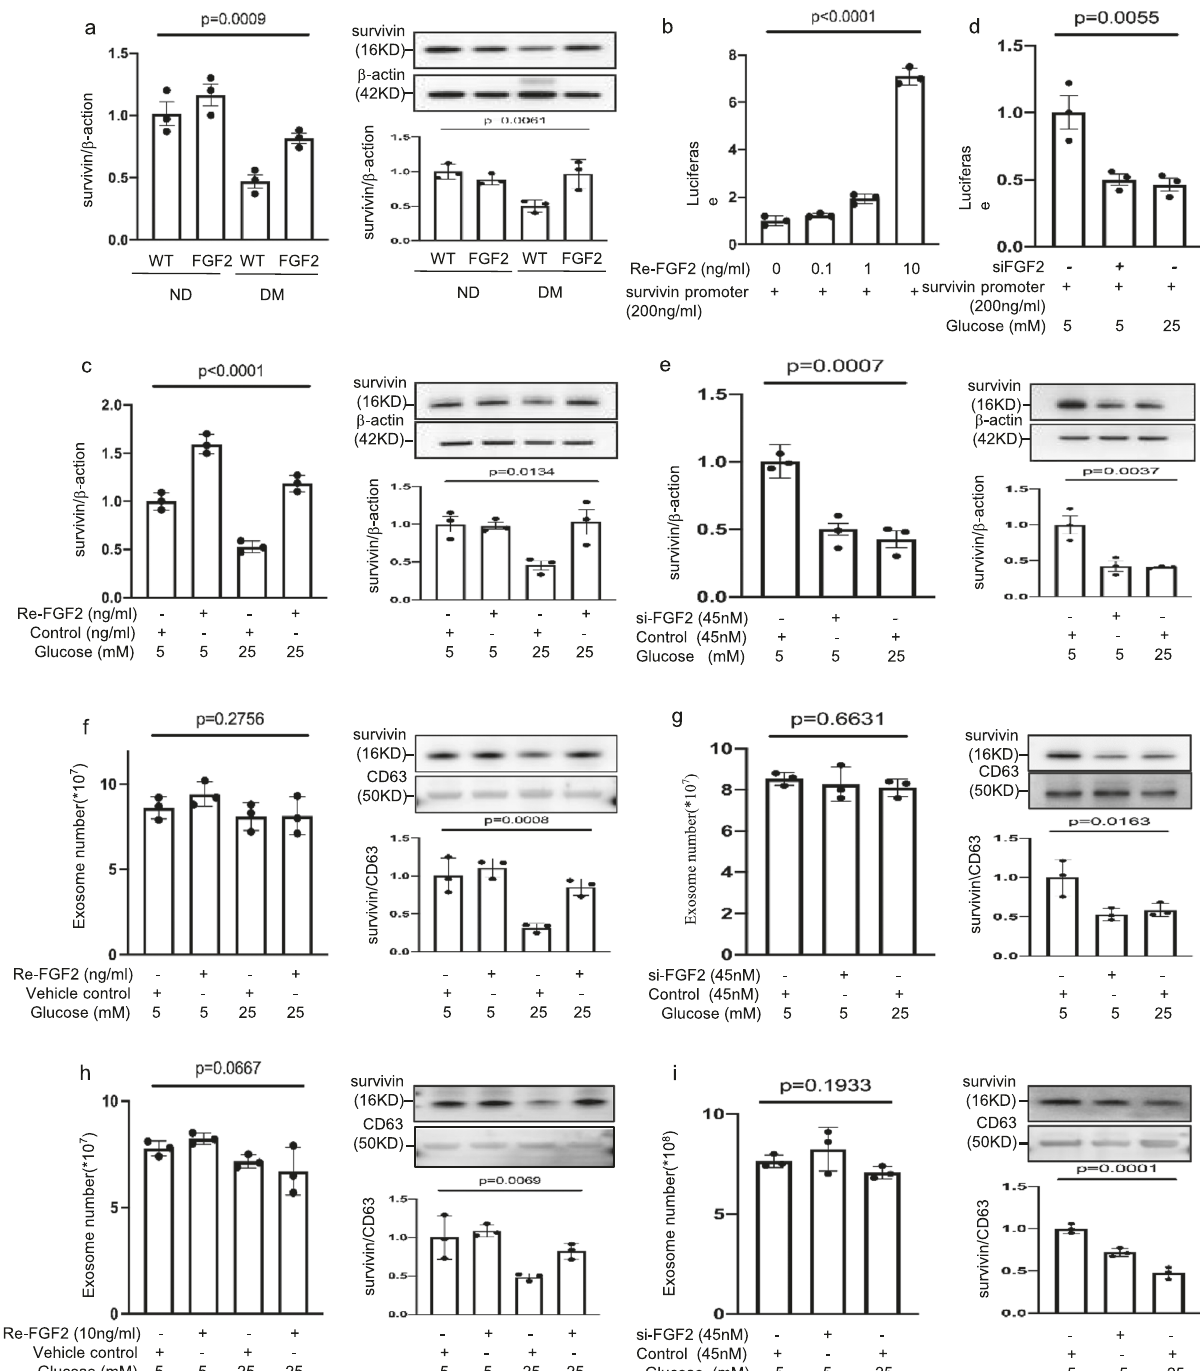
Fig. 4 FGF2 induces Survivin expression and enriches Survivin in exosomes. a Survivin mRNA and protein abundance in E8.5 wild type (WT) and FGF2 Tg embryos from nondiabetic or diabetic dams. b Luciferase reporter activity driven by the Survivin promoter. Re-FGF2: human recombinant FGF2. c Survivin mRNA and protein expression in normal glucose (NG; 5 mM glucose) and high glucose (HG; 25 mM glucose) culture conditions with Re-FGF2. d Luciferase reporter activity driven by the Survivin promoter. si-FGF2: siRNA FGF2. e Survivin mRNA and protein expression. f , g Exosome number and Survivin protein expression in exosomes treated by Re-FGF2 ( f ) or si-FGF2 ( g ). h , i Exosome number and Survivin protein expression in exosomes of isolated E8 Flk-1 + progenitors treated by Re-FGF2 ( h ) or si-FGF2 ( i ). In ( f , h ), the vehicle control is water (equal volume of Re-FGF2 solution). Cell culture experiments were performed three times ( n = 3). Cells experiments were repeated three times ( n = 3). Experiments were performed using three embryos from three different dam per group ( n = 3). * indicates signi fi cant difference ( P < 0.05) compared to other groups ( P < 0.05). ND nondiabetic, DM diabetes mellitus, WT wild type, FGF2 FGF2 transgenic mice.